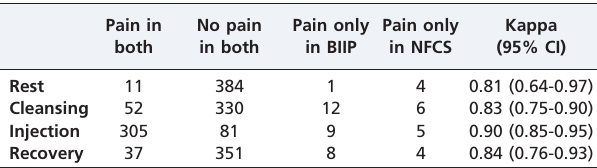
Table 4 - Agreement between the BIIP and NFCS behavioral scales for the 4 studied time